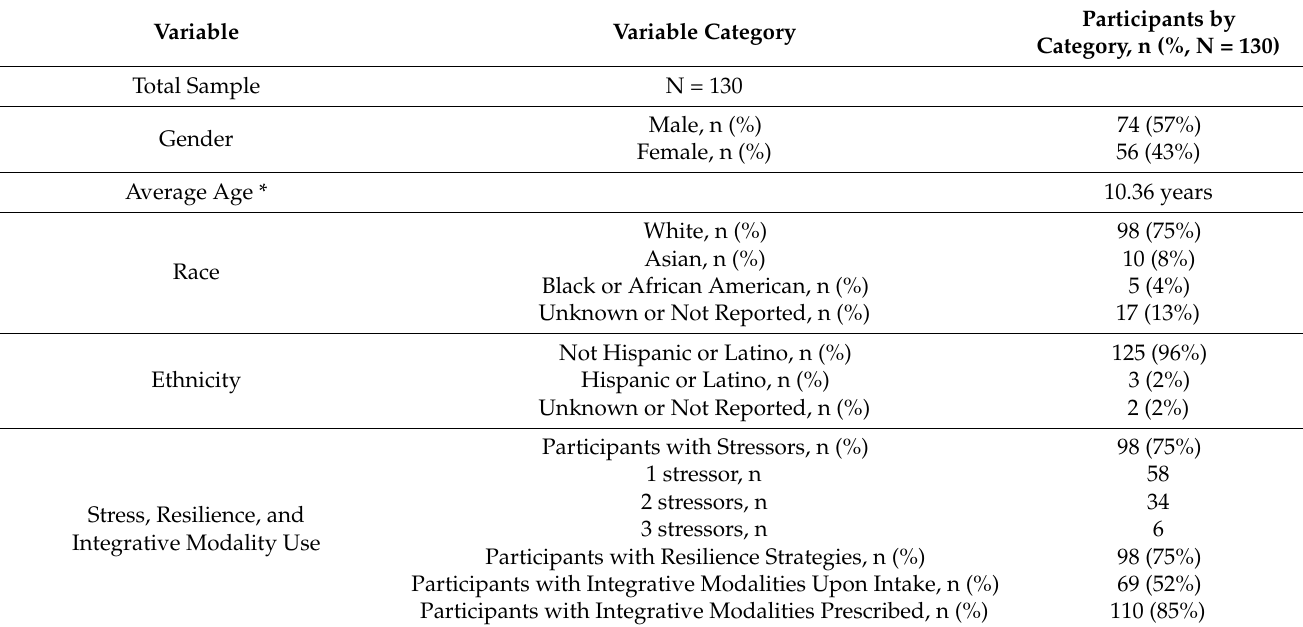
Table 1. Demographics of patient population presenting to FRC (N =